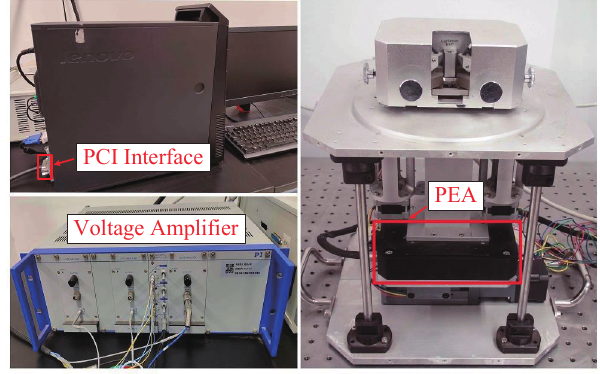
Figure 9. Experiment